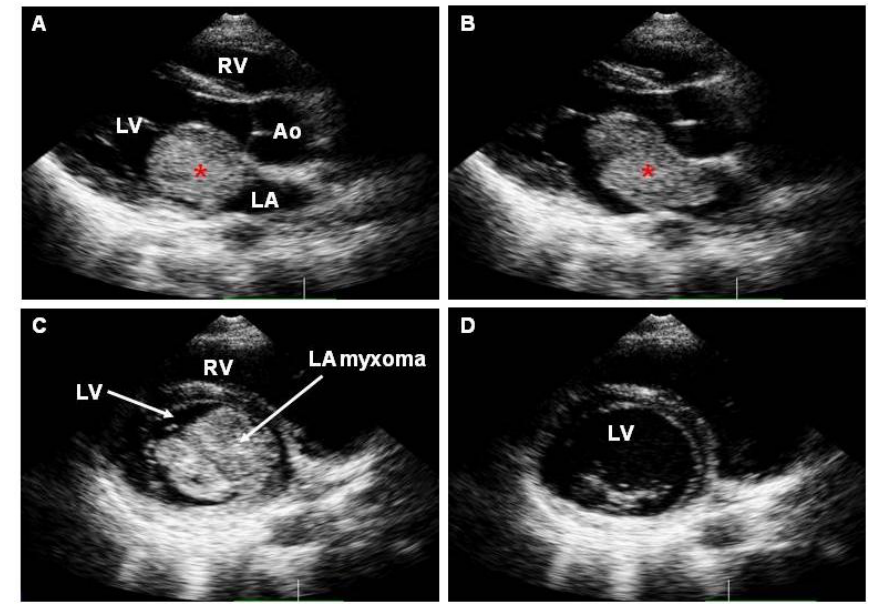
FIGURE 1. (A,B) Echocardiographic images of left atrial myxoma in parasternal long axis view (A, early diastolic; B, late diastolic). (C,D) Diastolic prolapse of the myxoma through the mitral valve (short axis view). LA, left atrium; LV, left ventricle; RV, right ventricle; Ao, Aorta, asterisk indicates myxoma.